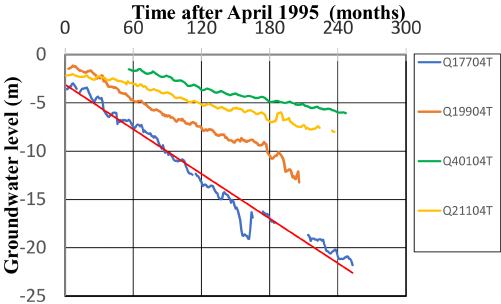
Figure 4. Example of drawdown in GW level with time in observa- tion wells (based on data from DWRPIS,